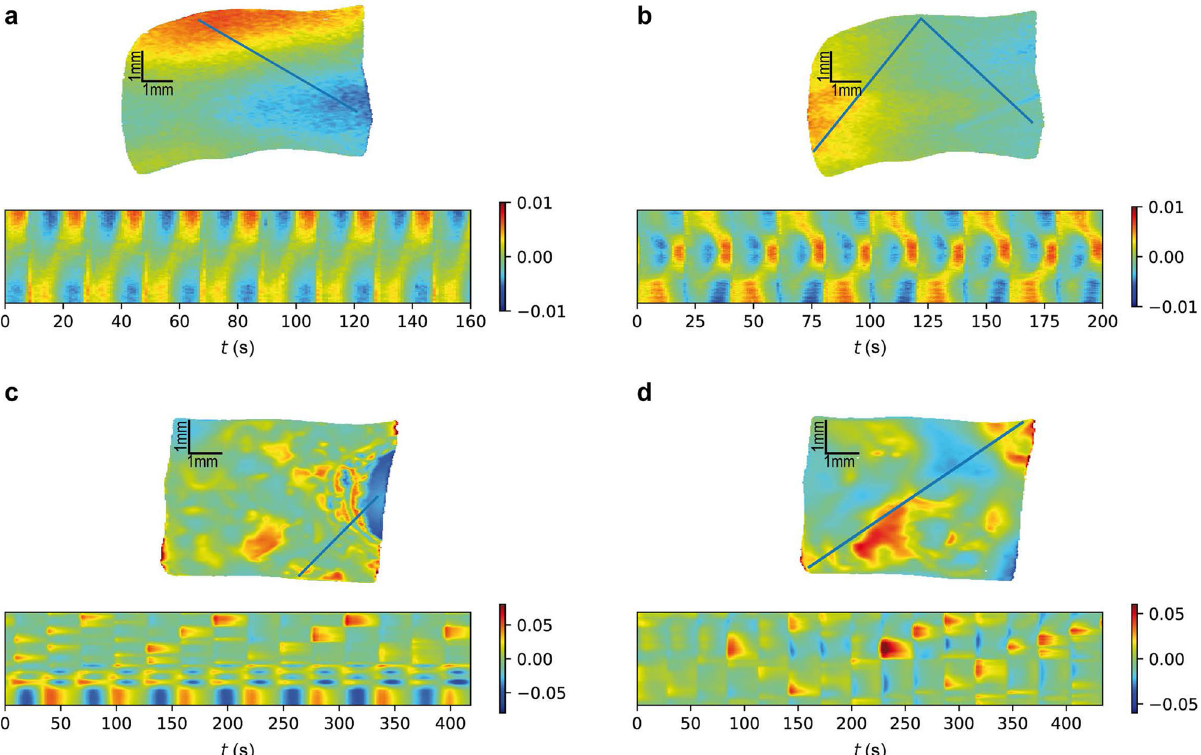
Fig. 9 Ellipsometric measurements of four different experimental states. Each state shows a snapshot of the electrode and the time series along a section on the electrode as indicated by the blue lines in the electrode snapshots. Note that the dynamics are shown in a rotating frame, where the uniform oscillation of the spatial average has been subtracted. a anti-phase two-cluster state, b subharmonic cluster state, c chimera state and d turbulent state. The size of the electrode in a and b is 6.0 × 4.3 mm (width × height), while in c and d it is 5.8 × 4.6 mm. For parameter values and experimental details, see the Methods